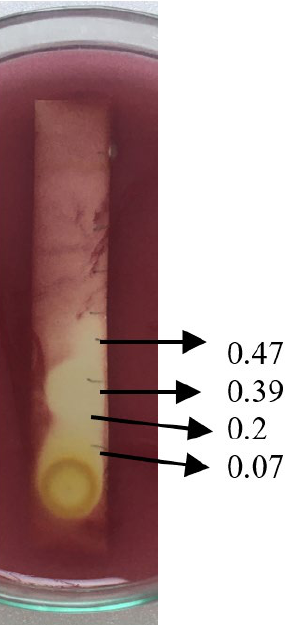
Fig. 11. Agar overlay bioautography of acetone extract of T.catappa leaf showing inhibition of S.aureus (clinical isolate) at Rf values 0.47, 0.39, 0.2 and